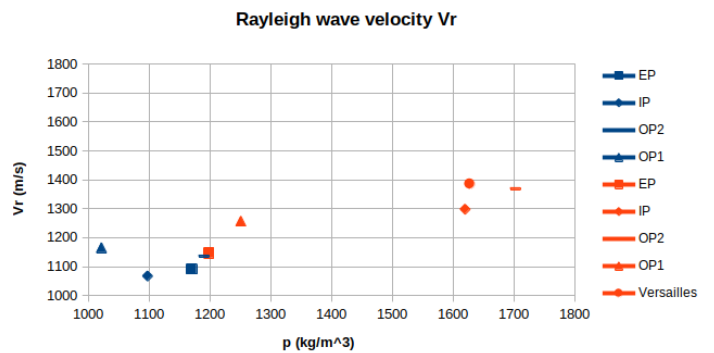
Figure 4. Rayleigh wave velocity as a function of density. Pure (blue) and composite (red) resins.